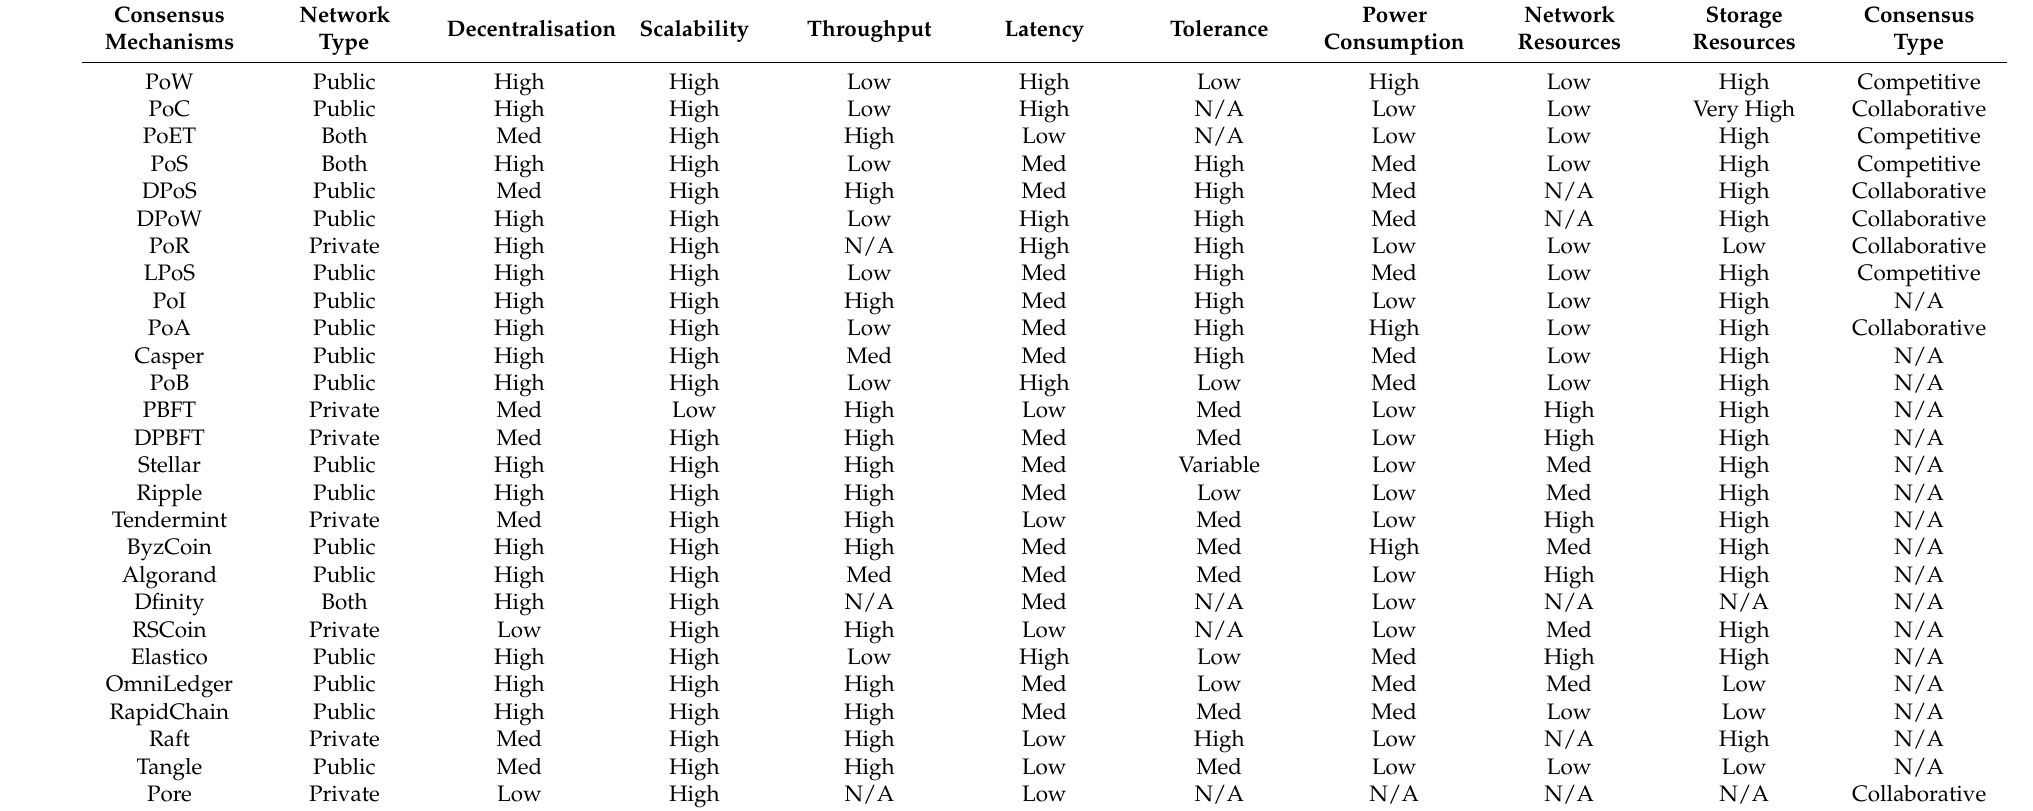
Table 1. Comparison of consensus mechanisms